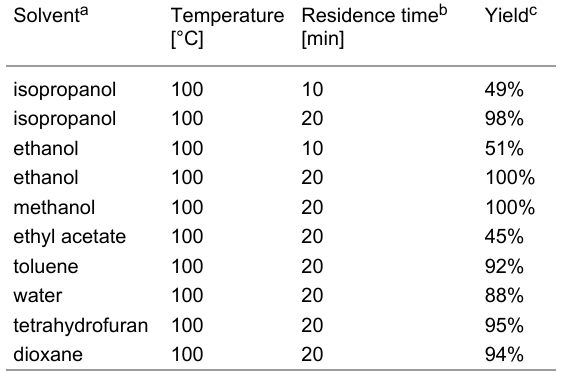
ly achieved within a 20 minute residence time at 100 °C